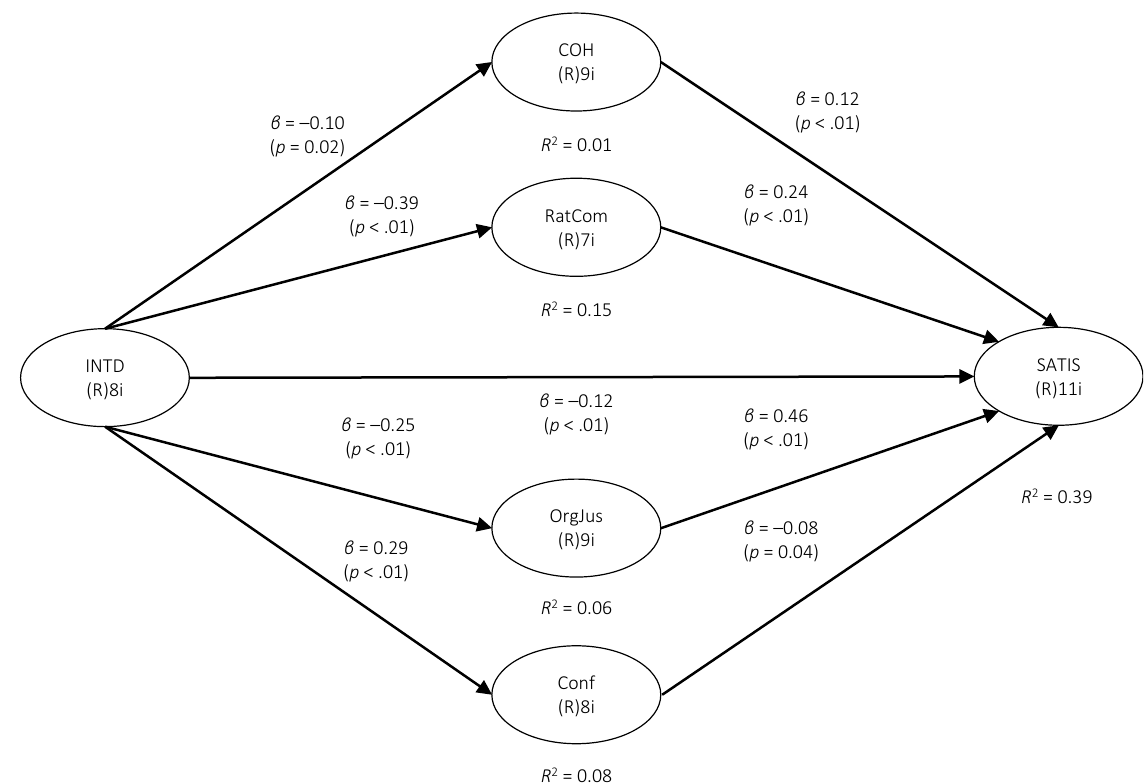
Figure 2. Results of the path analysis